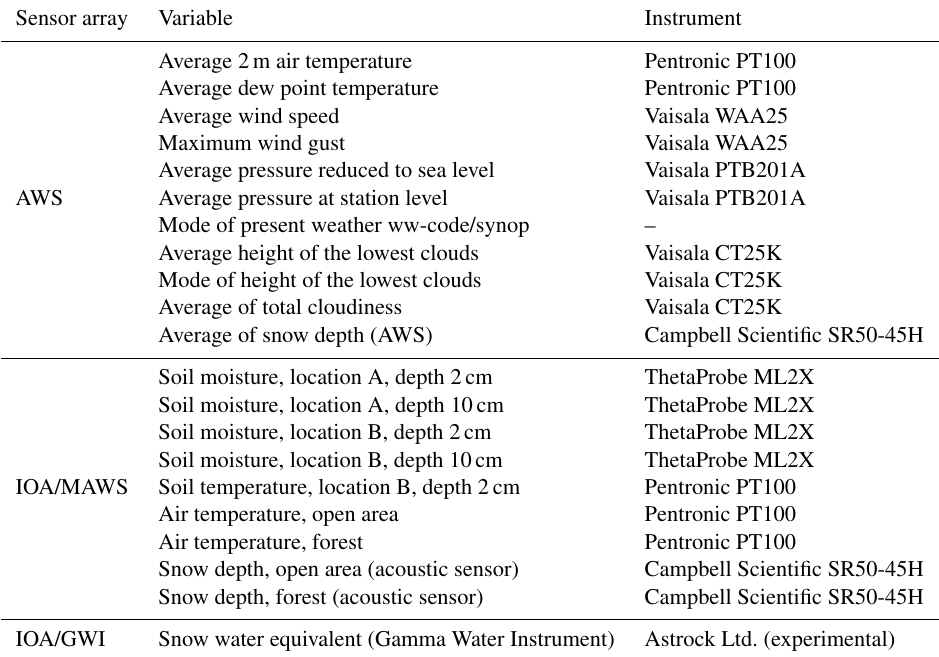
Table 3. Automated data collected in NoSREx consolidated datasets from Sodankylä mini automated weather station (MAWS), the IOA automated weather station and the IOA Gamma Water